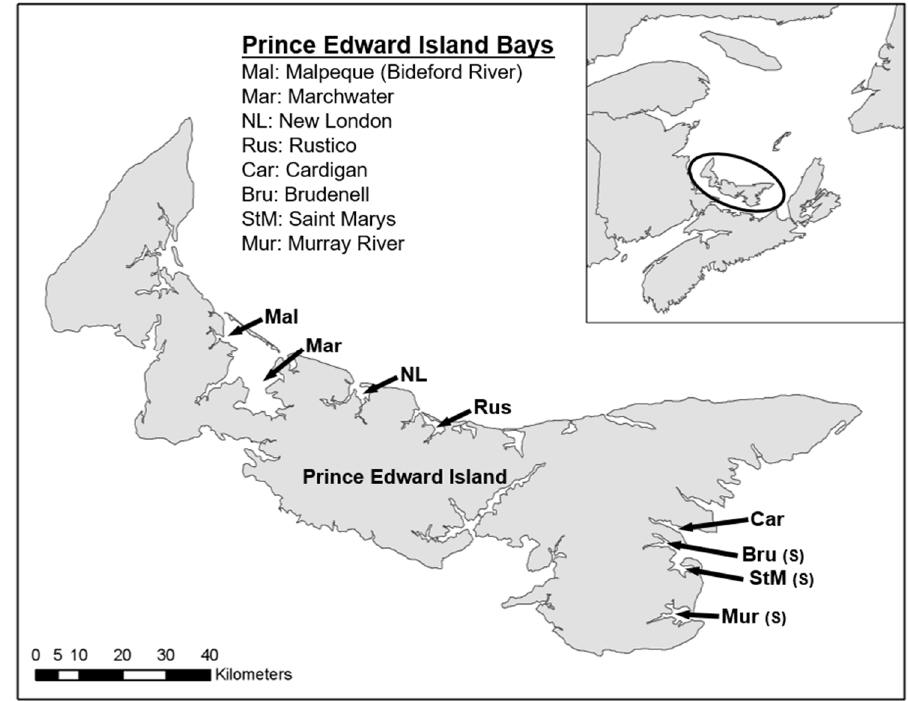
Figure 1. The Maritime Provinces of Canada, with insert of Prince Edward Island showing bays sampled. (S) indicates bays with Styela clava . Table 1. Estimated total bay area, flushing time, and area leased for mussel culture and % of bay leased for mussel grow-out in 2005, for each bay sampled (data from Fisheries and Oceans Canada, Charlottetown, 2007). (S) indicates bays with Styela clava . Except for where indicated, farming in all sites was started in the early 1980s [43].